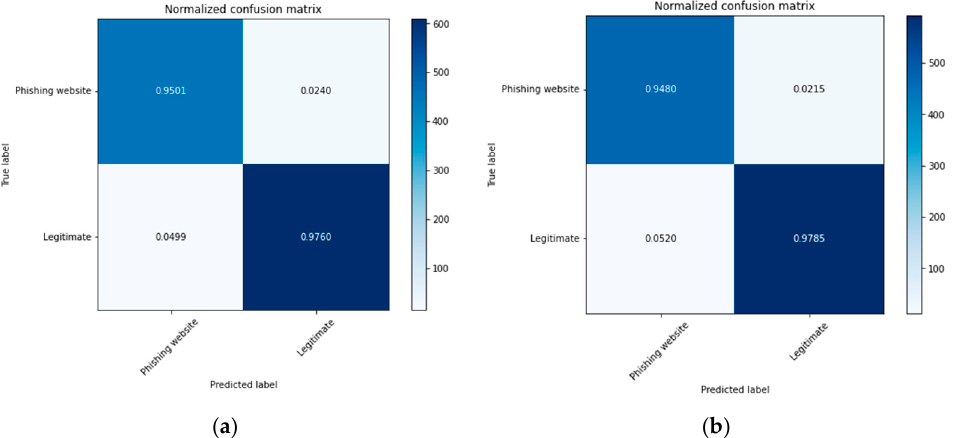
Figure 8. A normalized confusion matrix of LightGBM for phishing website and legitimate website classification: ( a ) with default parameters; ( b ) with optimized parameters for Dataset 1.